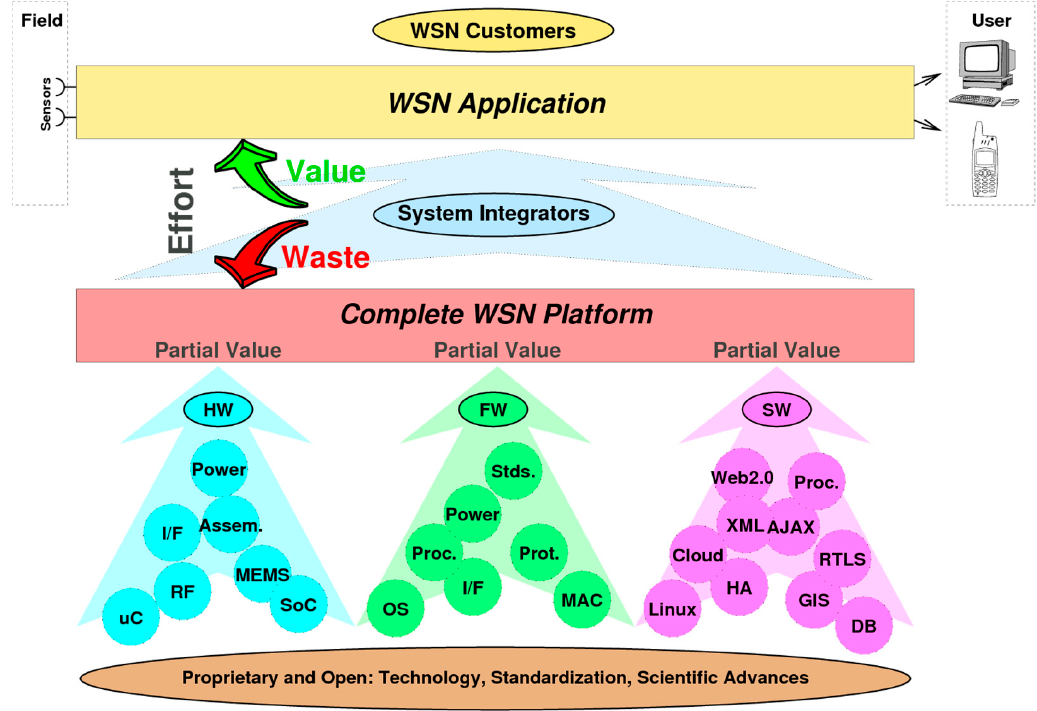
Figure 1. WSN-DPCM toolset helps system integrators to focus on customer requirements by hiding most structural and implementation details of WSN platform components.